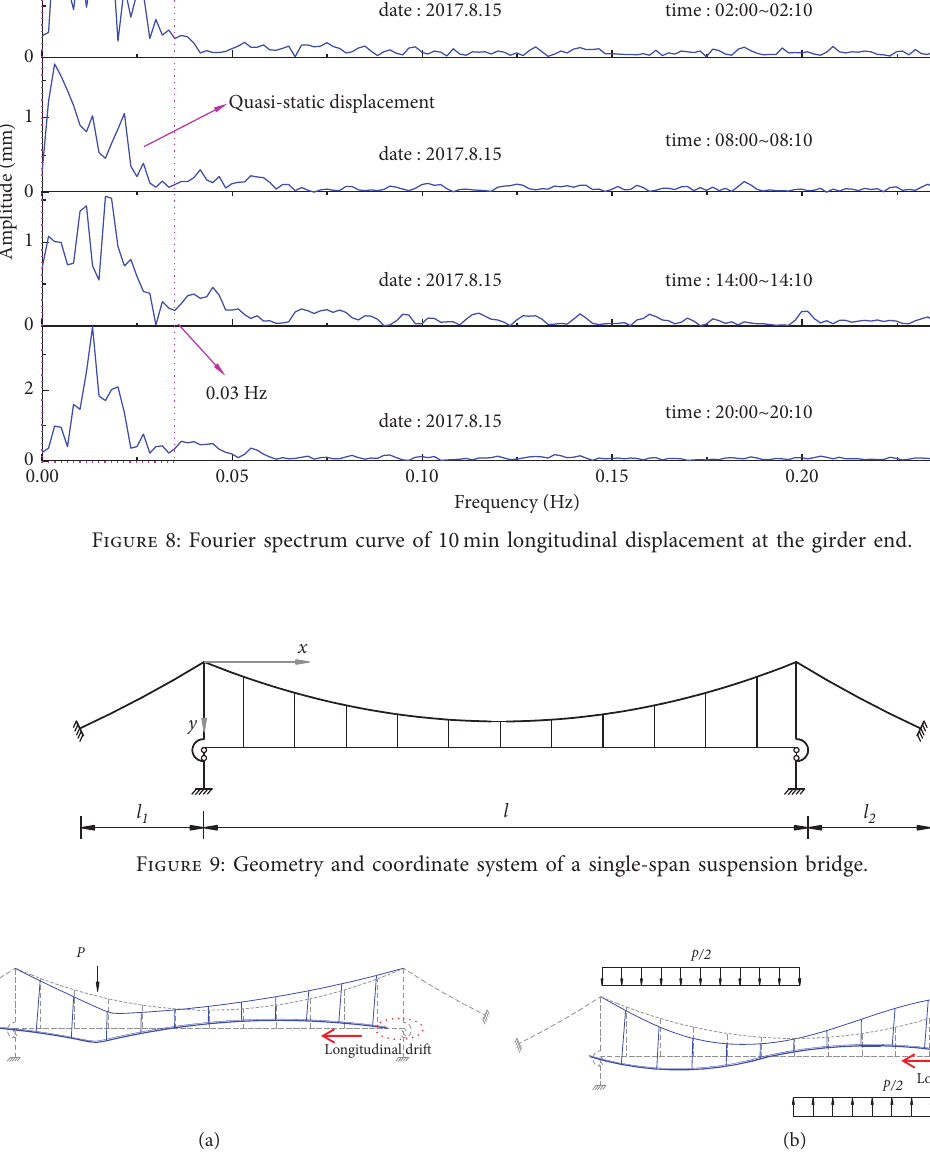
Figure 10: Deformation of a suspension bridge under asymmetric load: (a) a single vertical load case; (b) antisymmetric uniformly distributed load